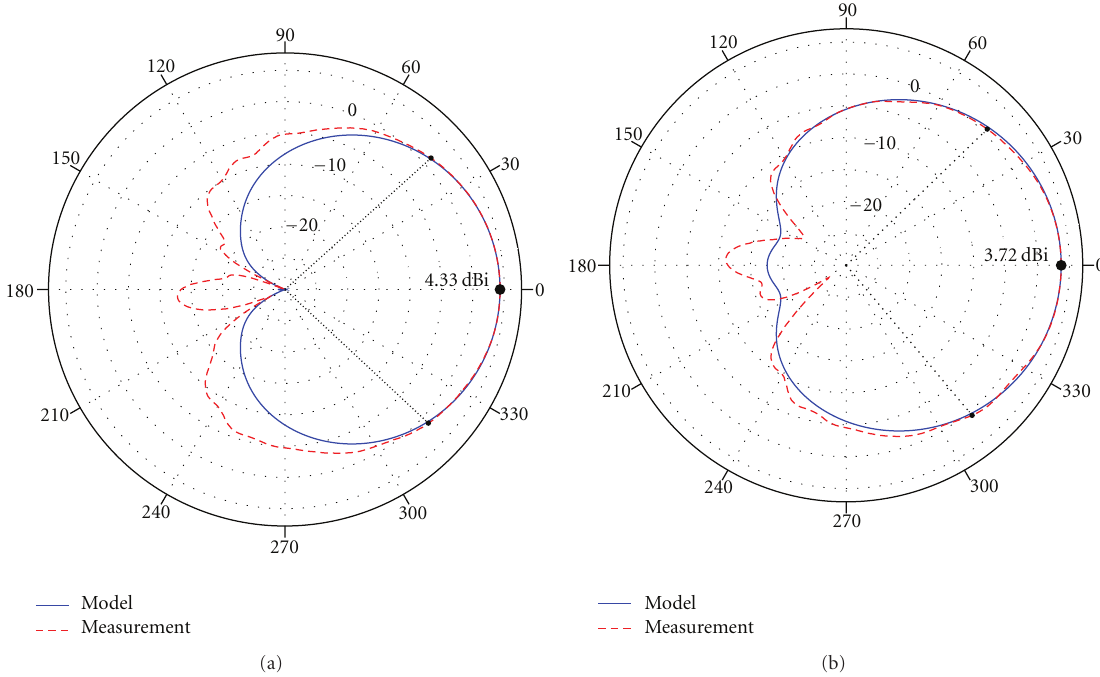
Figure 8: Radiation pattern in XY plane of prototype 2 for 1.573 GHz when bent in the L p direction. The bending radii are 90 mm (a) and 40mm (b).